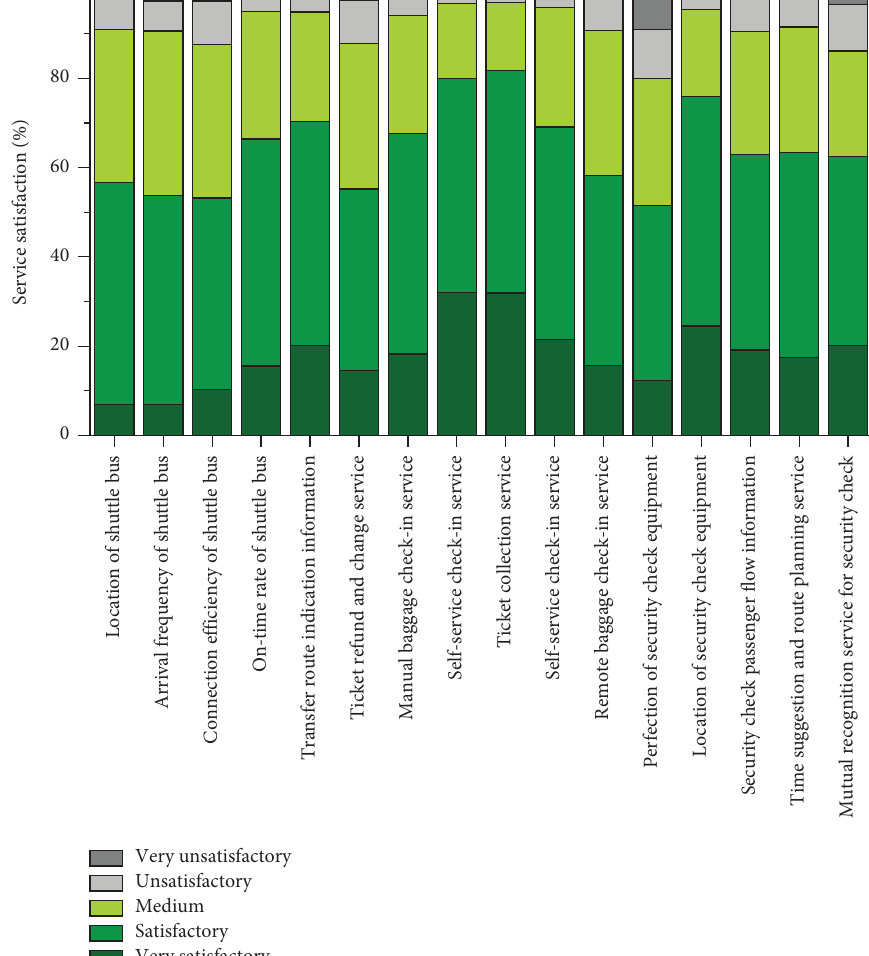
Figure 4: Satisfaction of all links of air-rail integration